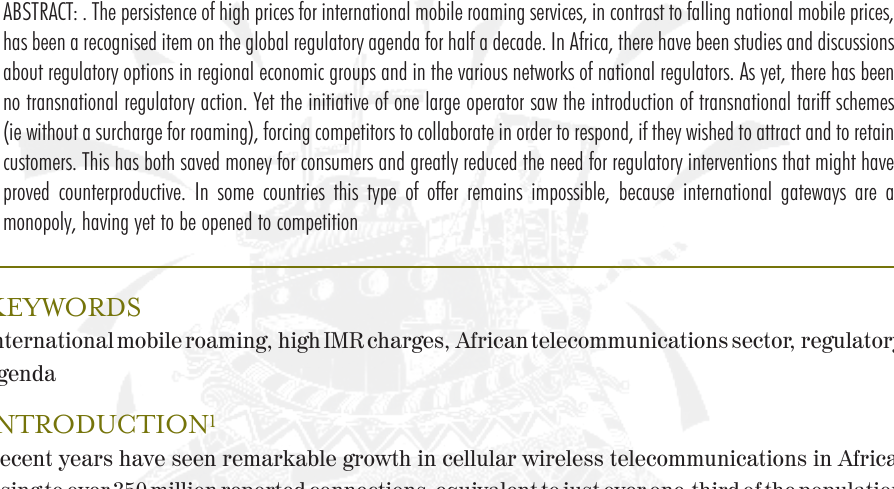
GROWTH OF MOBILE CONNECTIONS IN